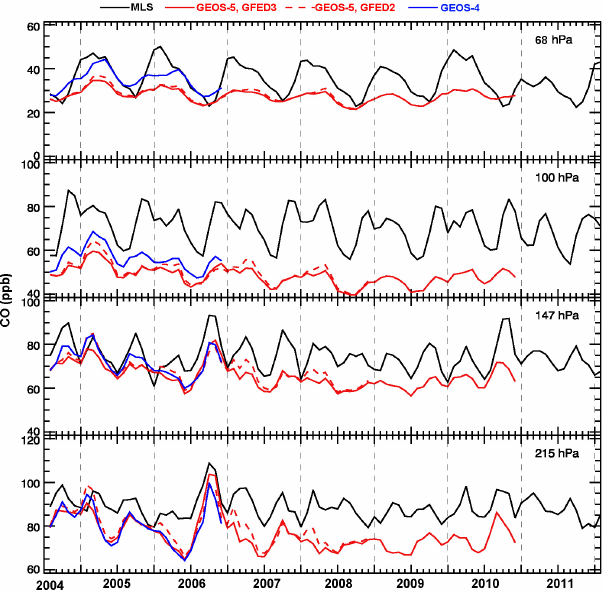
Fig. 1. Temporal variation of monthly mean MLS CO and model CO mixing ratios zonally-averaged over 10 ◦ S to 10 ◦ N at 215hPa, 147hPa, 100hPa and 68hPa. Black solid lines show MLS obser- vations. Red solid lines show model results from GEOS-5 using GFED3 emissions and red dashed lines show those using GFED2 emissions. Blue lines show model results from GEOS-4 using GFED2